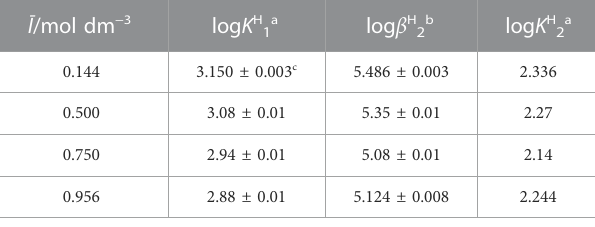
TABLE 2Protonation constants of alginate ( Alg 2- )atdifferent ionic strengthsin NaCl (aq) and T =